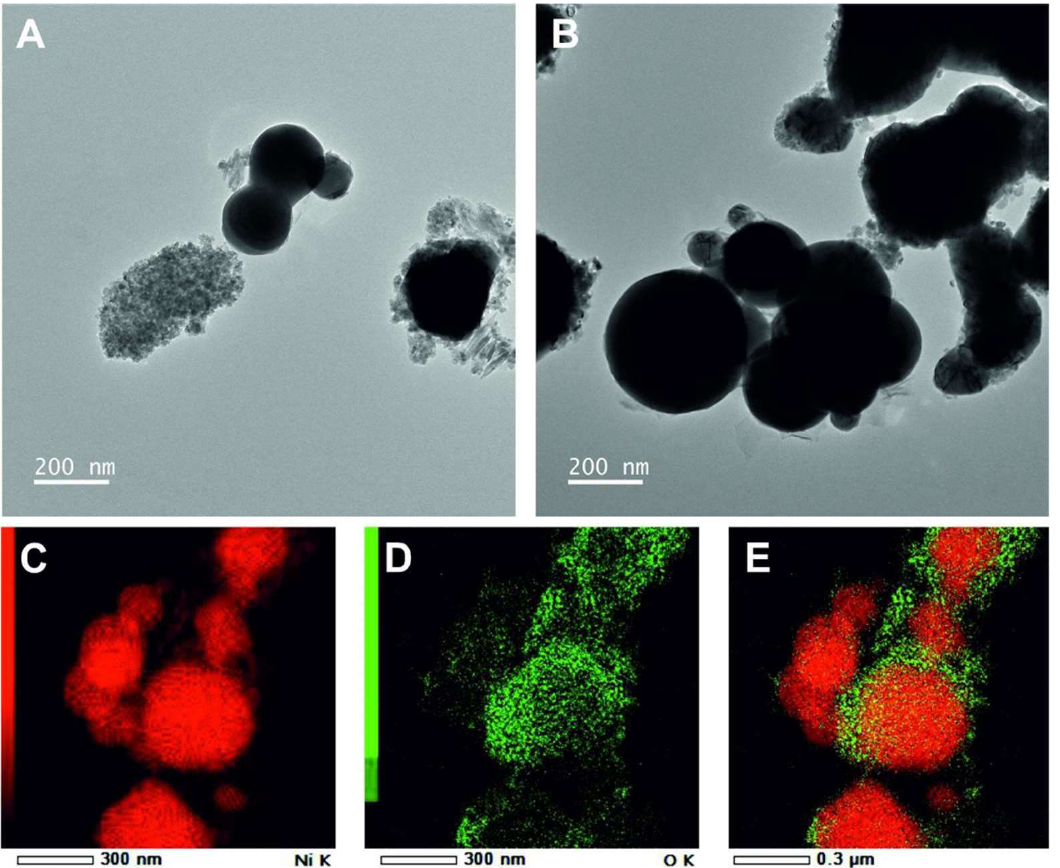
Figure 1. Analysis of nanoparticles and dot-mapping of nickel by transmission electron microscopy (TEM). The upper panel presents the morphology of nickel ( A , B ). The lower panel shows the dot- mapping of nickel and oxygen ( C – E ). Dot-mapping of nickel ( C ). Dot-mapping of nickel oxide ( D ). The merged representation of nickel and oxygen ( E ). This panel shows the oxygen distribution on the surface of nickel